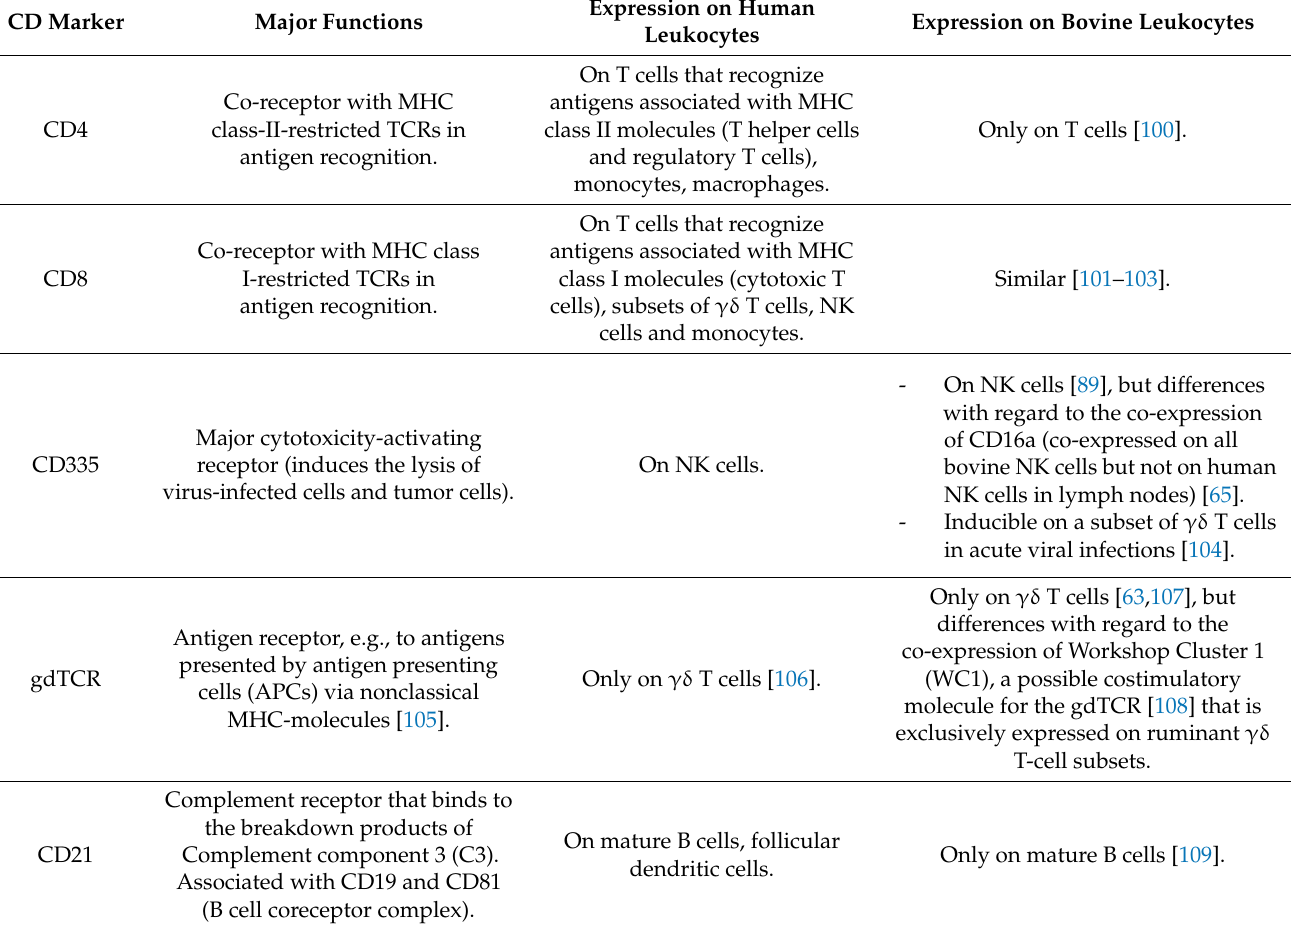
Table 4. Differences in the surface marker expression of human and bovine lymphocytes. Apart from the indicated references, References [98,99] were investigated to collect the presented